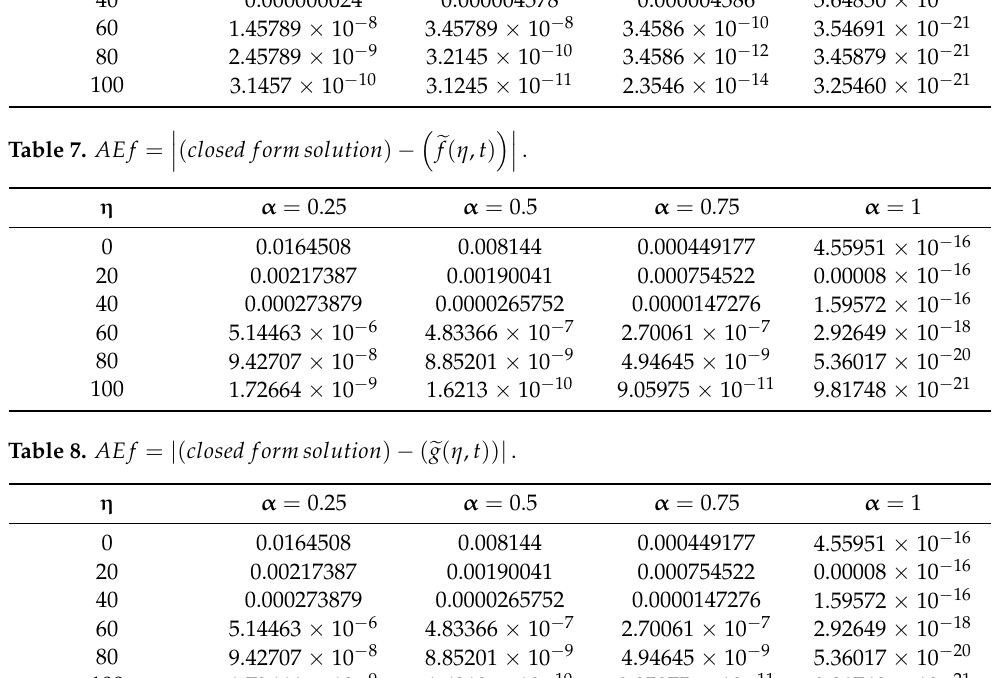
(cid:12) (cid:12) ( closed form solution ) − (cid:12)